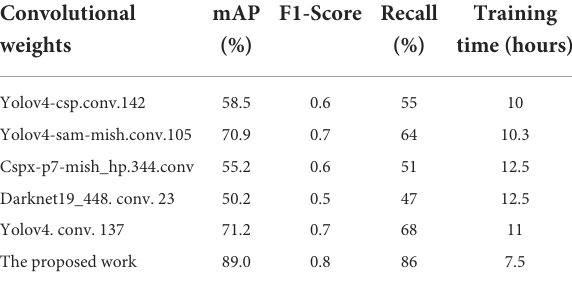
TABLE 4 Performance comparison of the proposed model with other YOLO